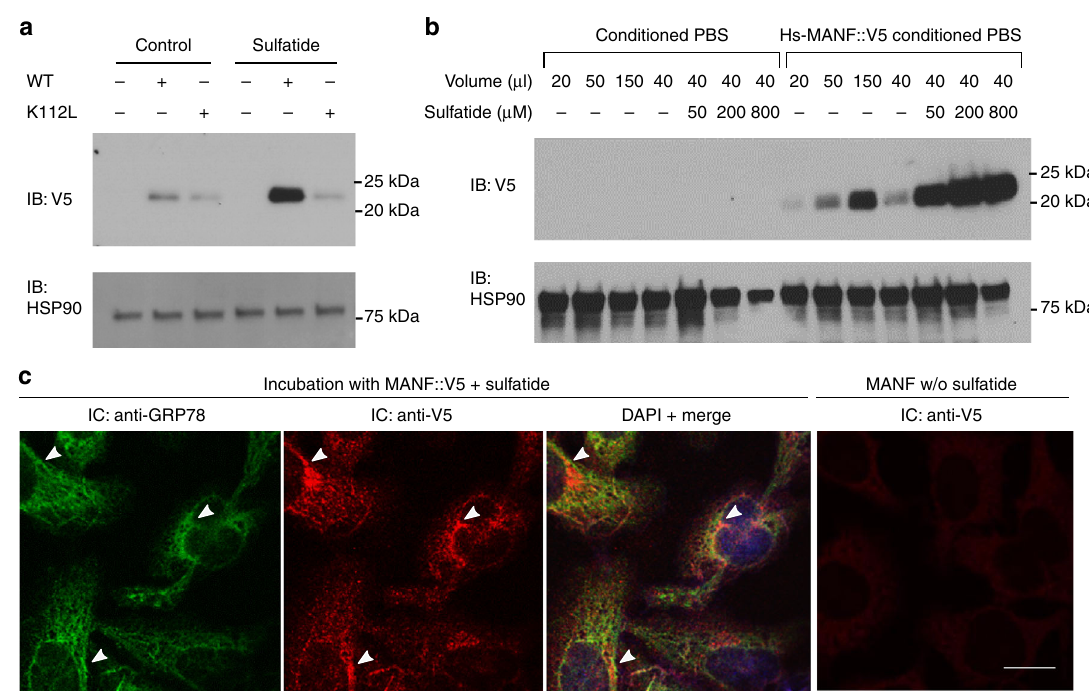
Fig. 5 Sulfatide promotes cellular uptake of MANF. a Exemplar western blot of lysates from target HEK293T cells treated with Hs-MANF or Hs-MANF (K112L) (puri fi ed from conditioned PBS of HEK293T-MANF::V5 cell lines) with or without sulfatide. b Exemplar western blot of lysates from target HEK293T cells treated with Hs-MANF (puri fi ed from conditioned PBS of HEK293T-MANF::V5 cell lines) with increasing doses of sulfatide added to the target HEK293T cell medium. c Exemplar immuno fl uorescence images of endogenous GPR78 (green) and V5-stained Hs-MANF (red), merged image with DAPI after incubation with Hs-MANF (puri fi ed from conditioned PBS of HEK293T-MANF::V5 cell lines) and with V5 staining of no-sulfatide control. Arrow heads indicate representative loci of co-localization. Scale bar, 20 µ